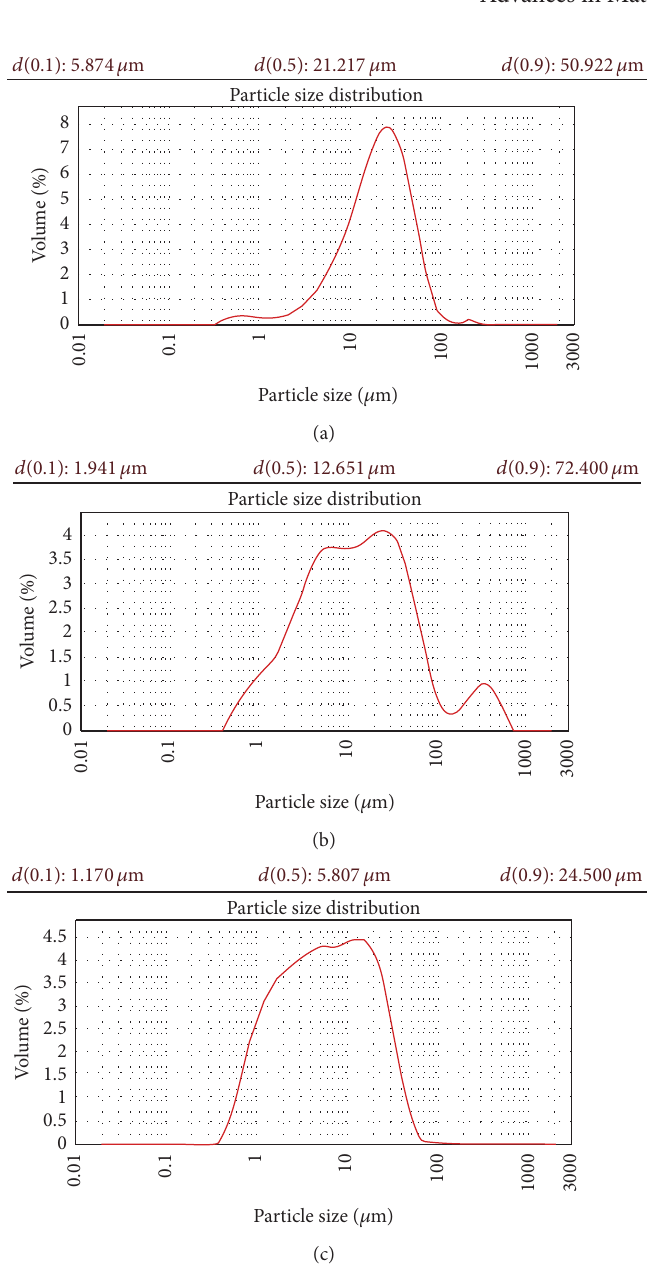
Figure 1: Particle size distributions of OPC (a), LGP12 (b), and LGP5